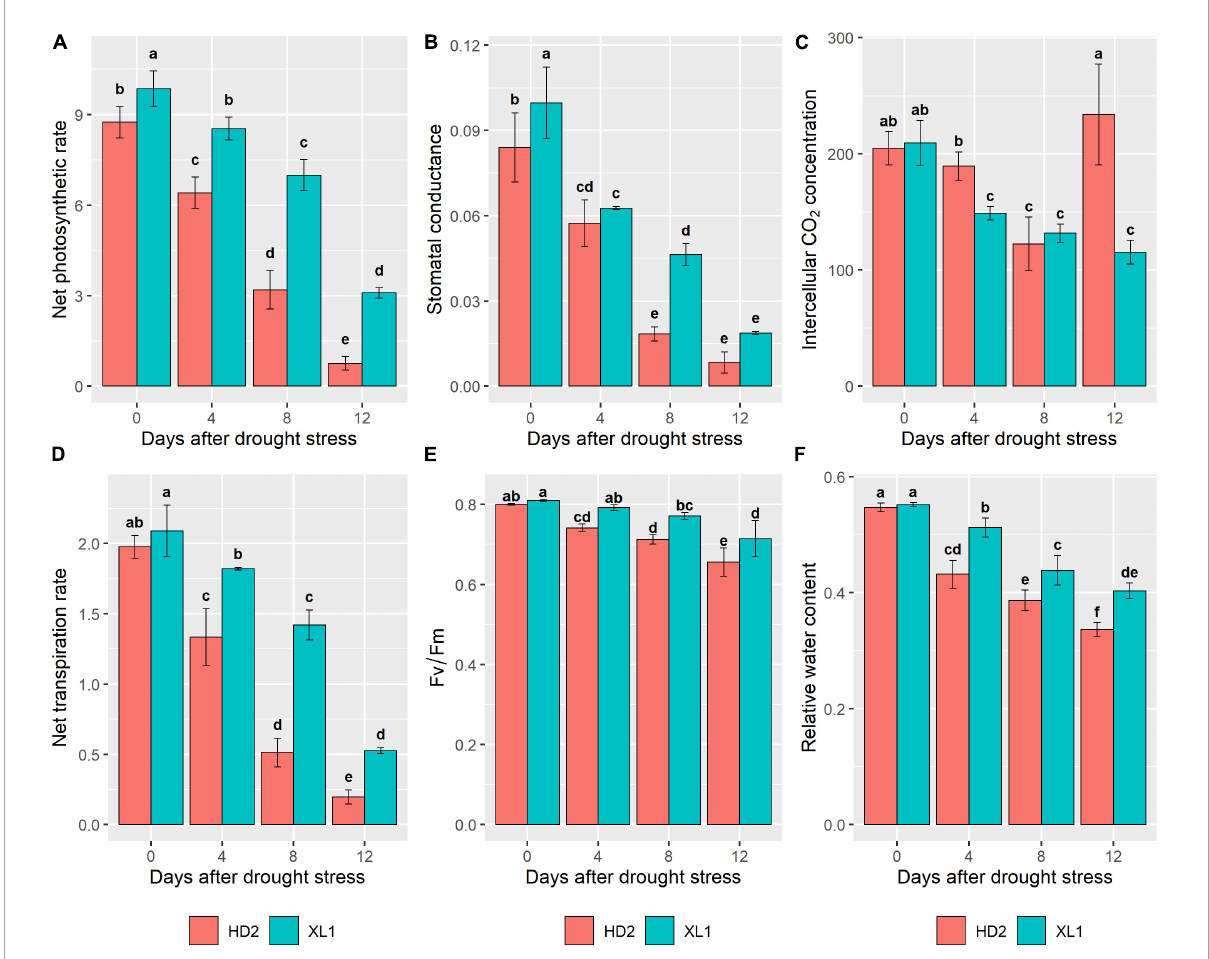
FIGURE1 The differences in photosynthetic parameters between XL1 and HD2 during the drought stress treatment. Net photosynthetic rate (P n ), Stomatal conductance (G s ), Intercellular CO 2 concentration (C i ), and Net transpiration rate (T r ) of both XL1 and HD2 leaves were measured by LI-6400XT between 8 and 11 a.m. local time. (A) Mean of the P n , (B) mean of the G s , (C) mean of the C i , (D) mean of the T r , (E) mean of the Fv/Fm, and (F) mean of the relative water content. Each data point represents the average of three biological replicates. Error bars represent mean ± SE. Different lowercase letters indicate significant differences at P < 0.05.